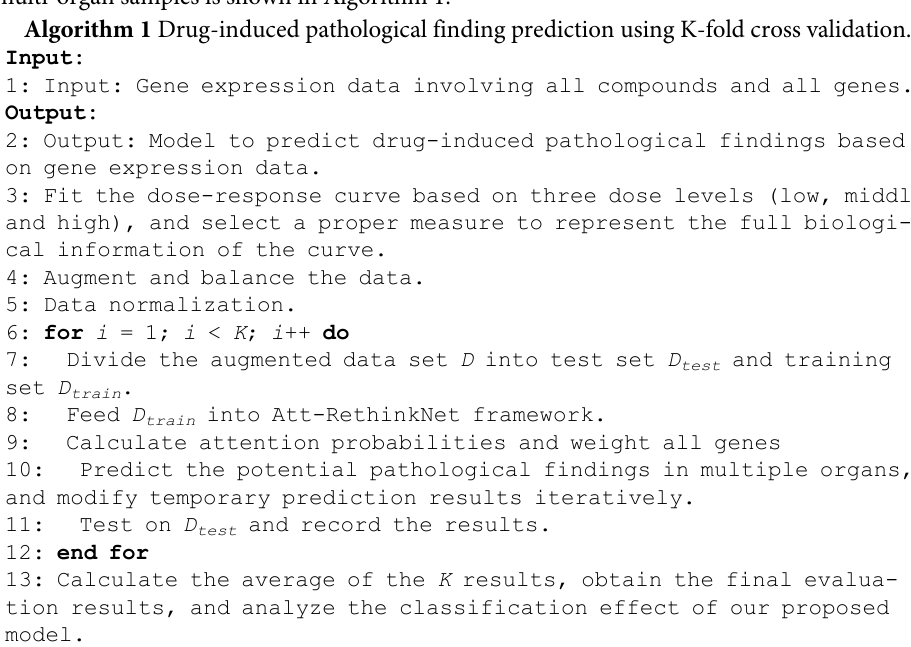
Algorithm 1 Drug-induced pathological finding prediction using K-fold cross